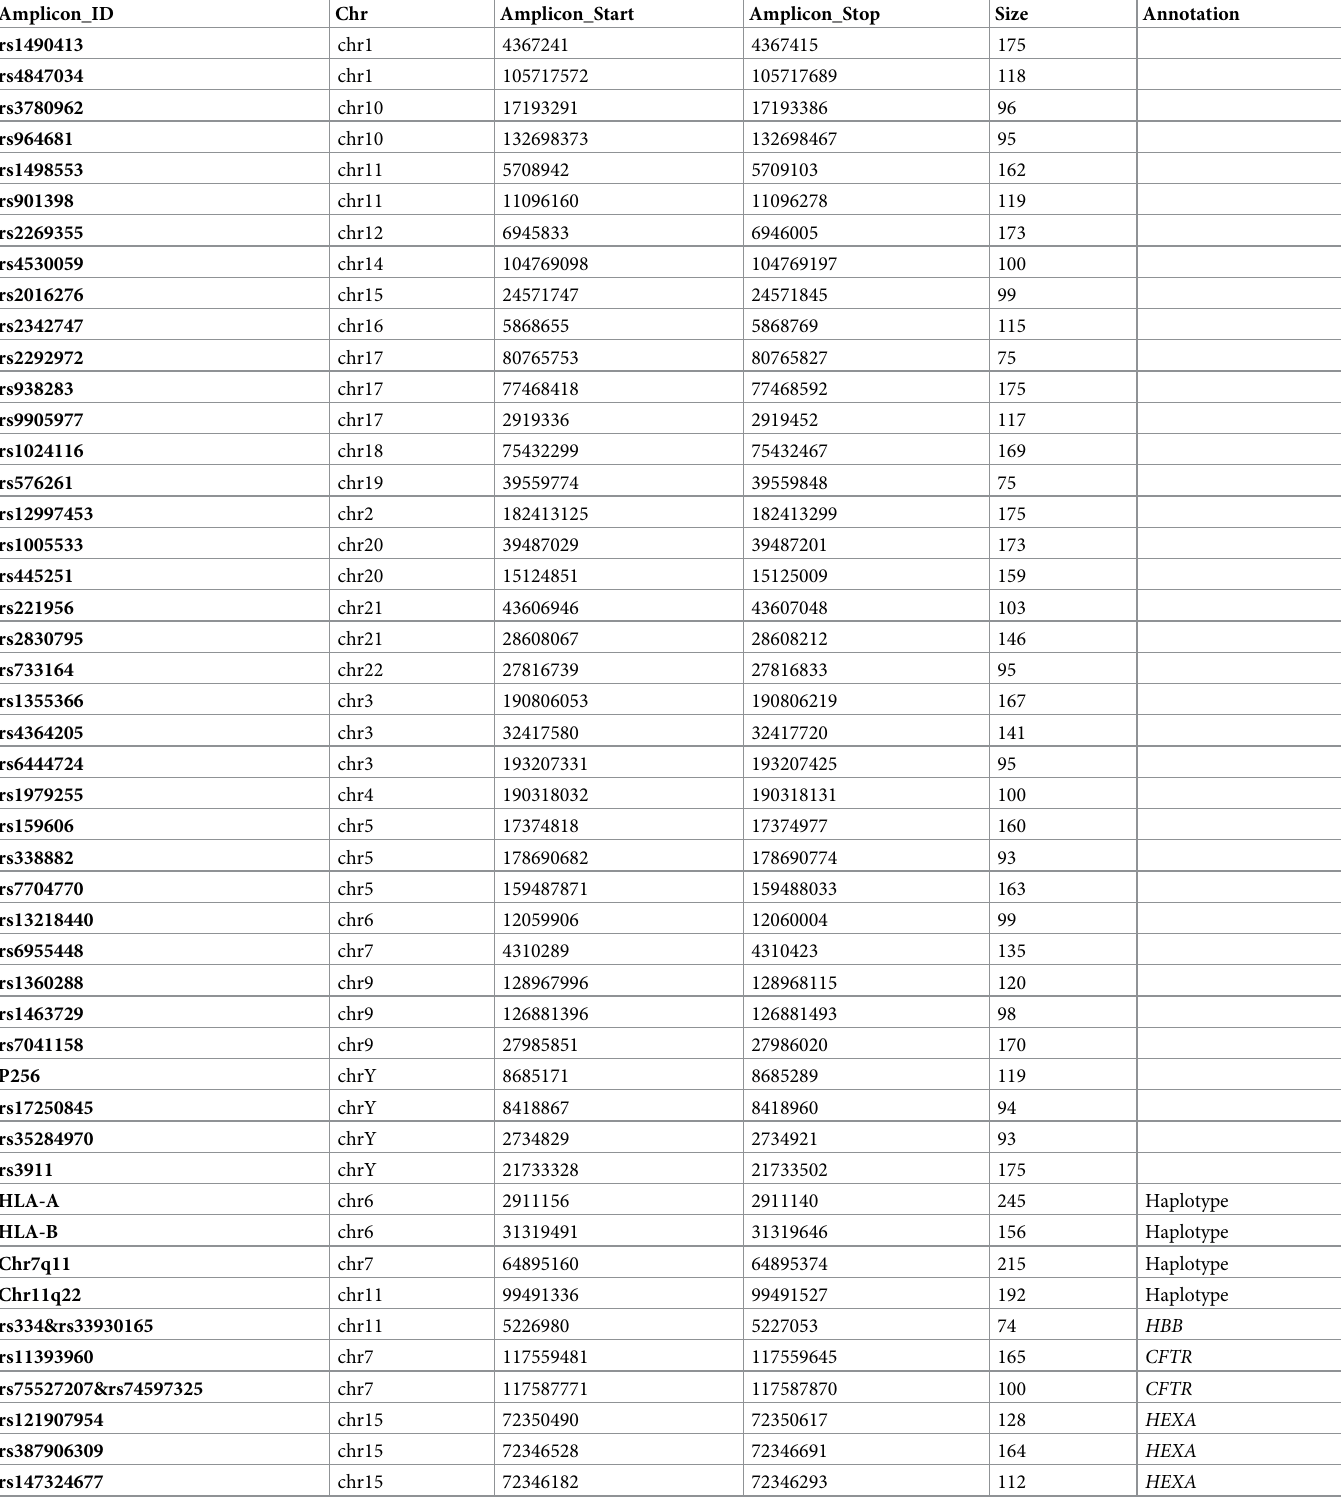
Table 1. List of